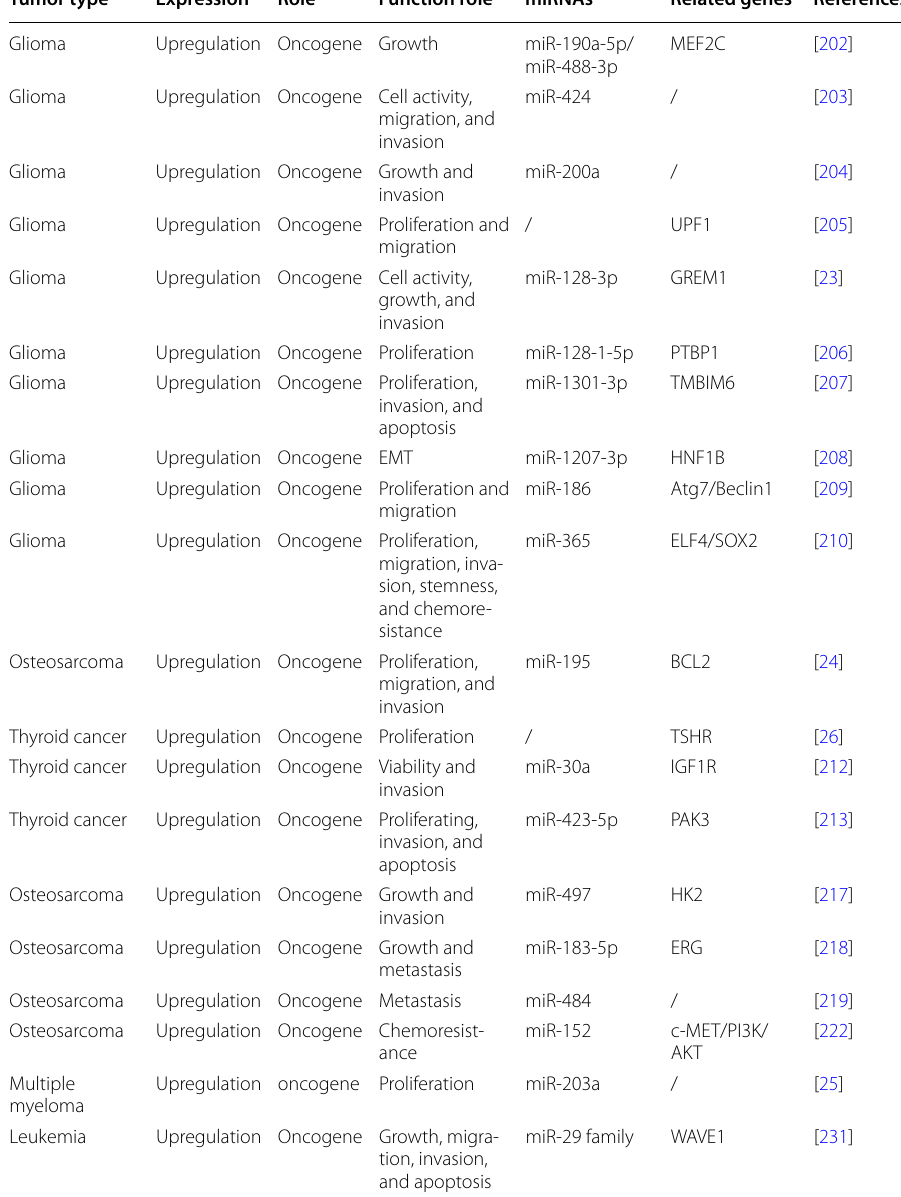
Table 11 Functional characterization of PVT1 in tumors of other systems Tumor